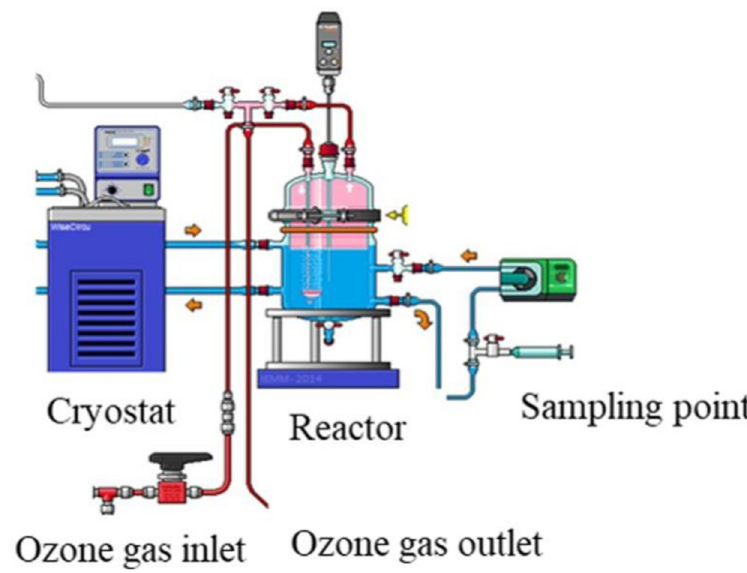
Figure 2. Experimental setup of ozonation bench-scale